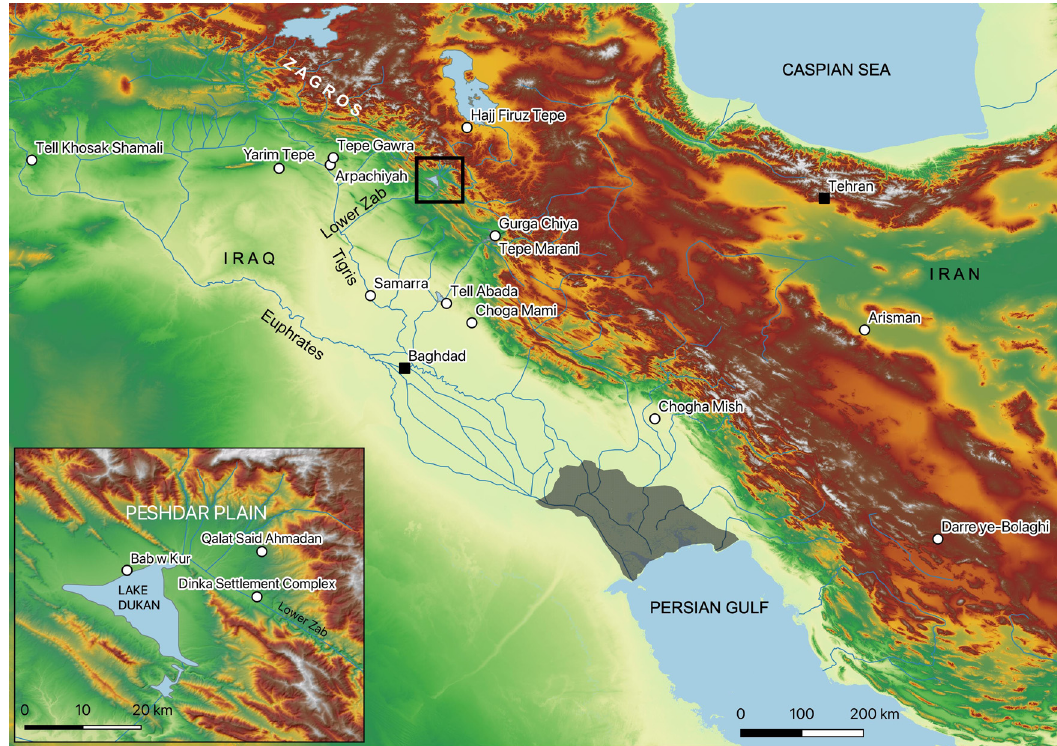
Figure 1: Map showing the sites mentioned in the text ( white dots ) along with the main modern cities ( black squares ) . The inset shows the location of the Dinka Settlement Complex in the Peshdar Plain. Prepared by Andrea